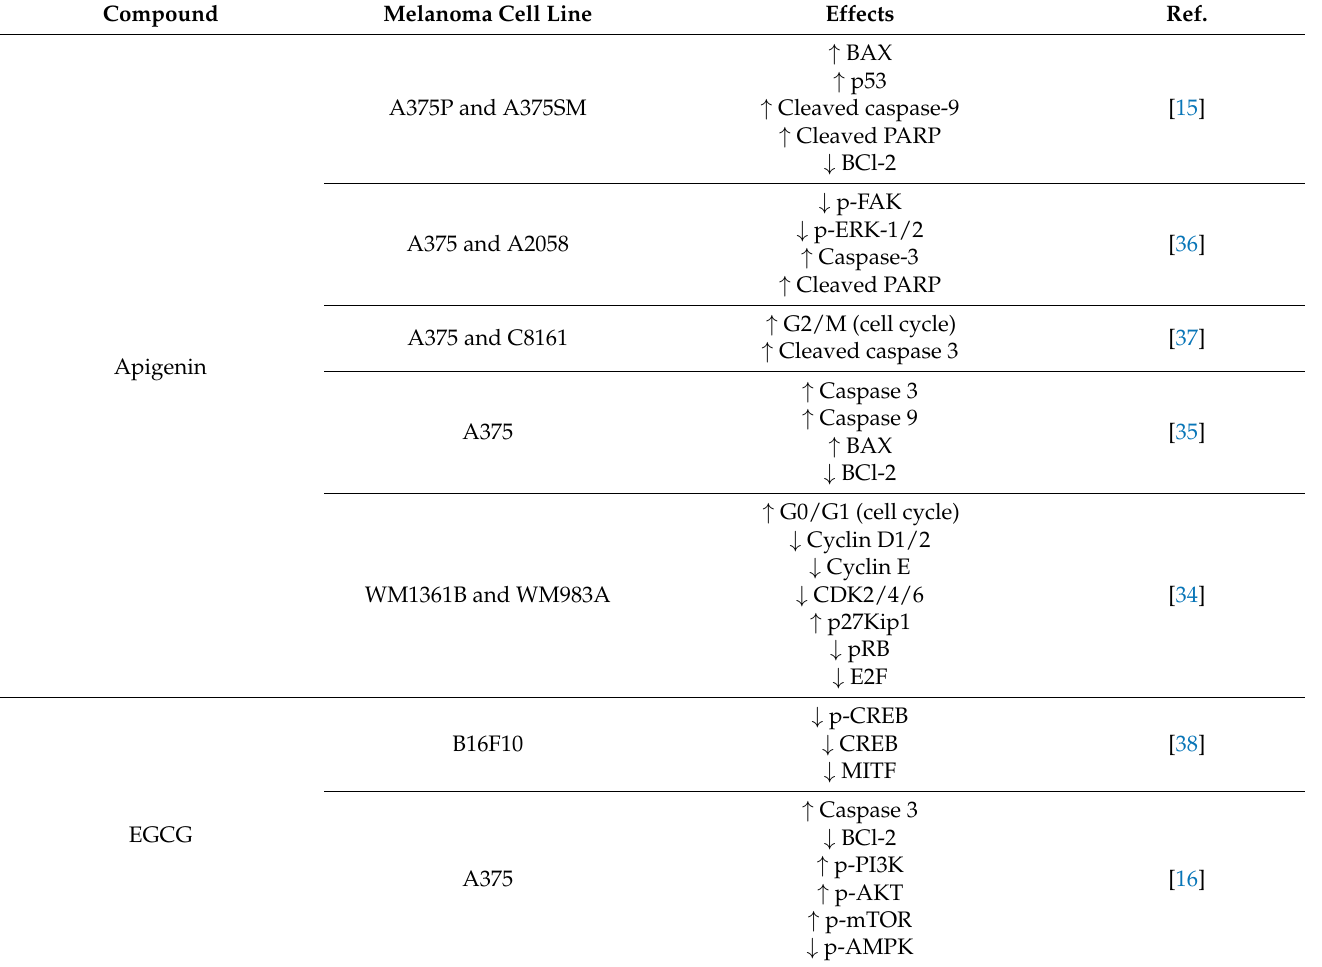
Table 1. A summary of the key proteins and genes that are targets to the selected flavonoid com- pounds. The effect of flavonoids on the cell cycle phases is also highlighted.